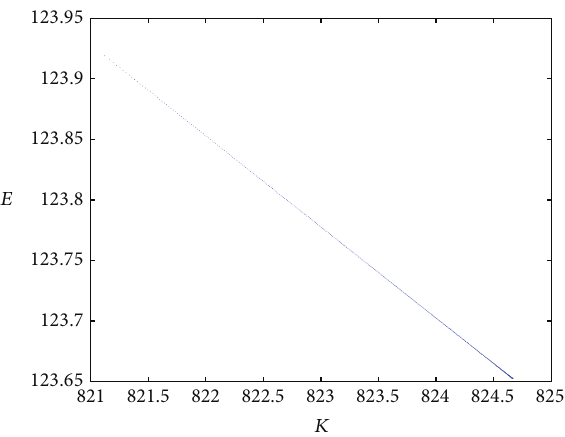
Figure 2: The total amount of network energy consumption of two- element source based on the rate-distortion function.